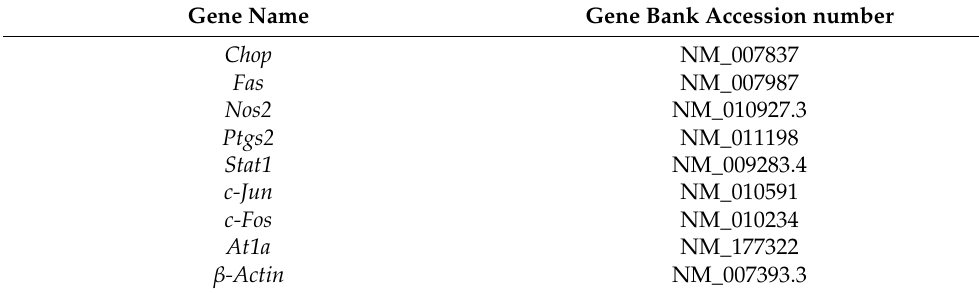
Table 1. Primers used in quantitative